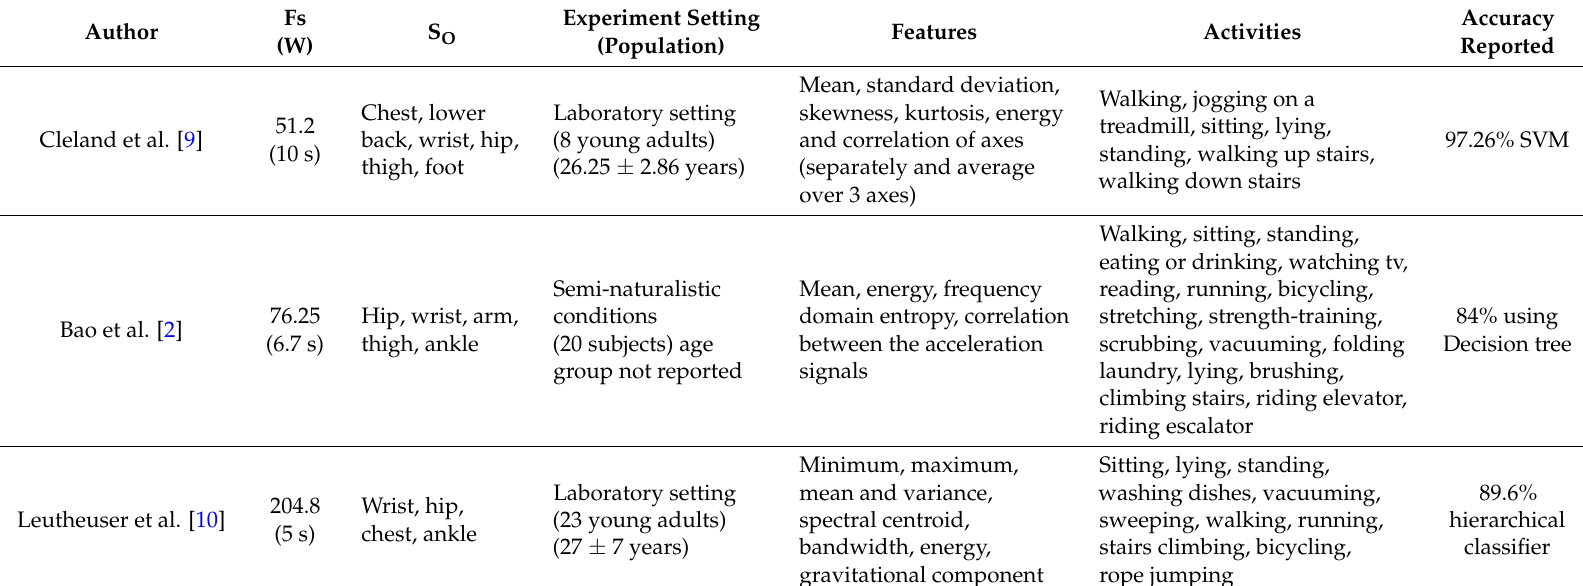
Table 5. Overview of the three SOA systems for PACs implemented in this study for performance